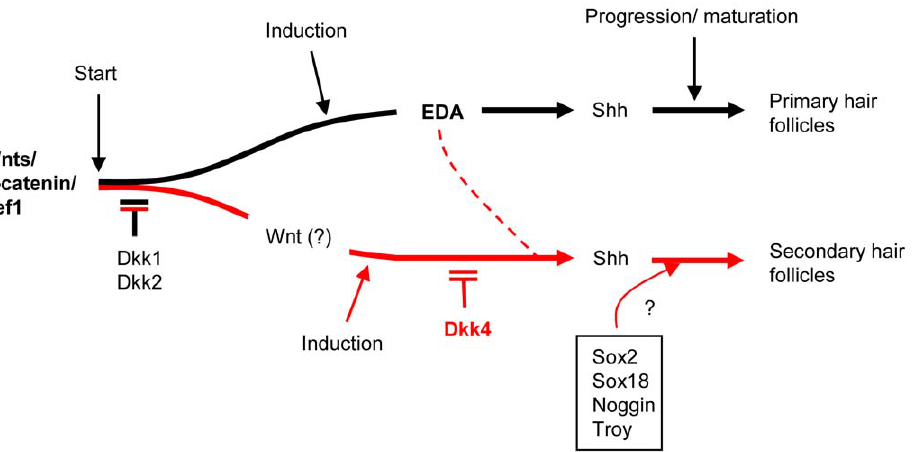
Figure 7. A schematic representation of the hypothesis for differential regulation of hair follicle subtype formation. Wnt/ b -catenin signaling is responsible for the development of all subtypes of hair follicles, a process that can be completely blocked by Dkk1 or Dkk2. Primary hair follicle formation is solely dependent on the Wnt-Eda-Shh cascade. A Dkk4-dependent pathway (red lines) regulates secondary hair follicle induction and differentiation, which is further mediated by Shh. Eda plays a modulatory role, as yet undefined in detail, in this process. Sox2, Sox18, Noggin and Troy may also regulate secondary hair follicle development, independent of Dkk4 action.